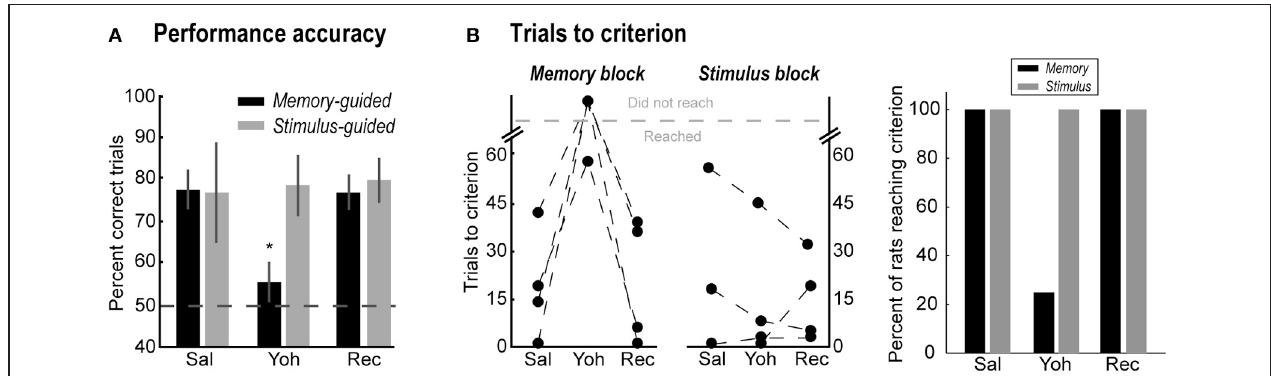
reach the performance criterion in the memory-guided trials (left panel) and in the stimulus-guided trials (right panel), and percent of rats that reached the criterion (rightmost